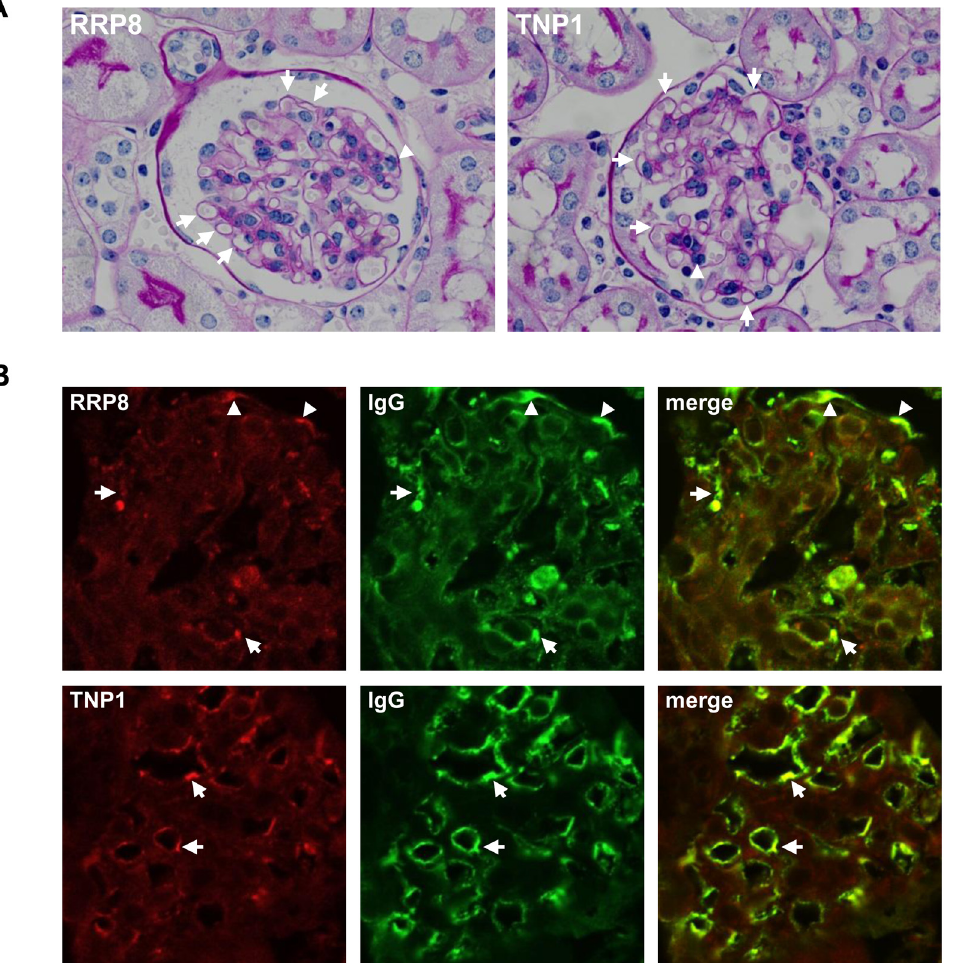
Fig 7. Double immunofluorescence of RRP8 or TNP1 and IgG in renal sections from RRP8-injected or TNP1-injected mice. Cryostat kidney sections from mice were analyzed by double immunofluorescence staining with a combination of anti-human RRP8 or anti-human TNP1 antibody and anti-mouse IgG antibody. The specimens were stained with Alexa 568-conjugated anti-RRP8 or anti-TNP1 antibodies (red) and with Alexa 488-conjugated anti-murine IgG antibody (green). (A) Photomicrograph of representative glomeruli of RRP8- and TNP1-injected mice (periodic acid-Schiff staining). Both manifested the slight enlargement of glomeruli with thickening of capillary wall (arrows) as well as the endocapillary proliferation with leukocytes (arrow head). (B) RRP8 signals coexisted with IgG signals in the sub-endothelial (arrows) and sub-epithelial (arrowhead) regions, exhibiting a granular pattern. On the other hand, TNP1 signals coexisted with IgG signals in the sub-epithelial region